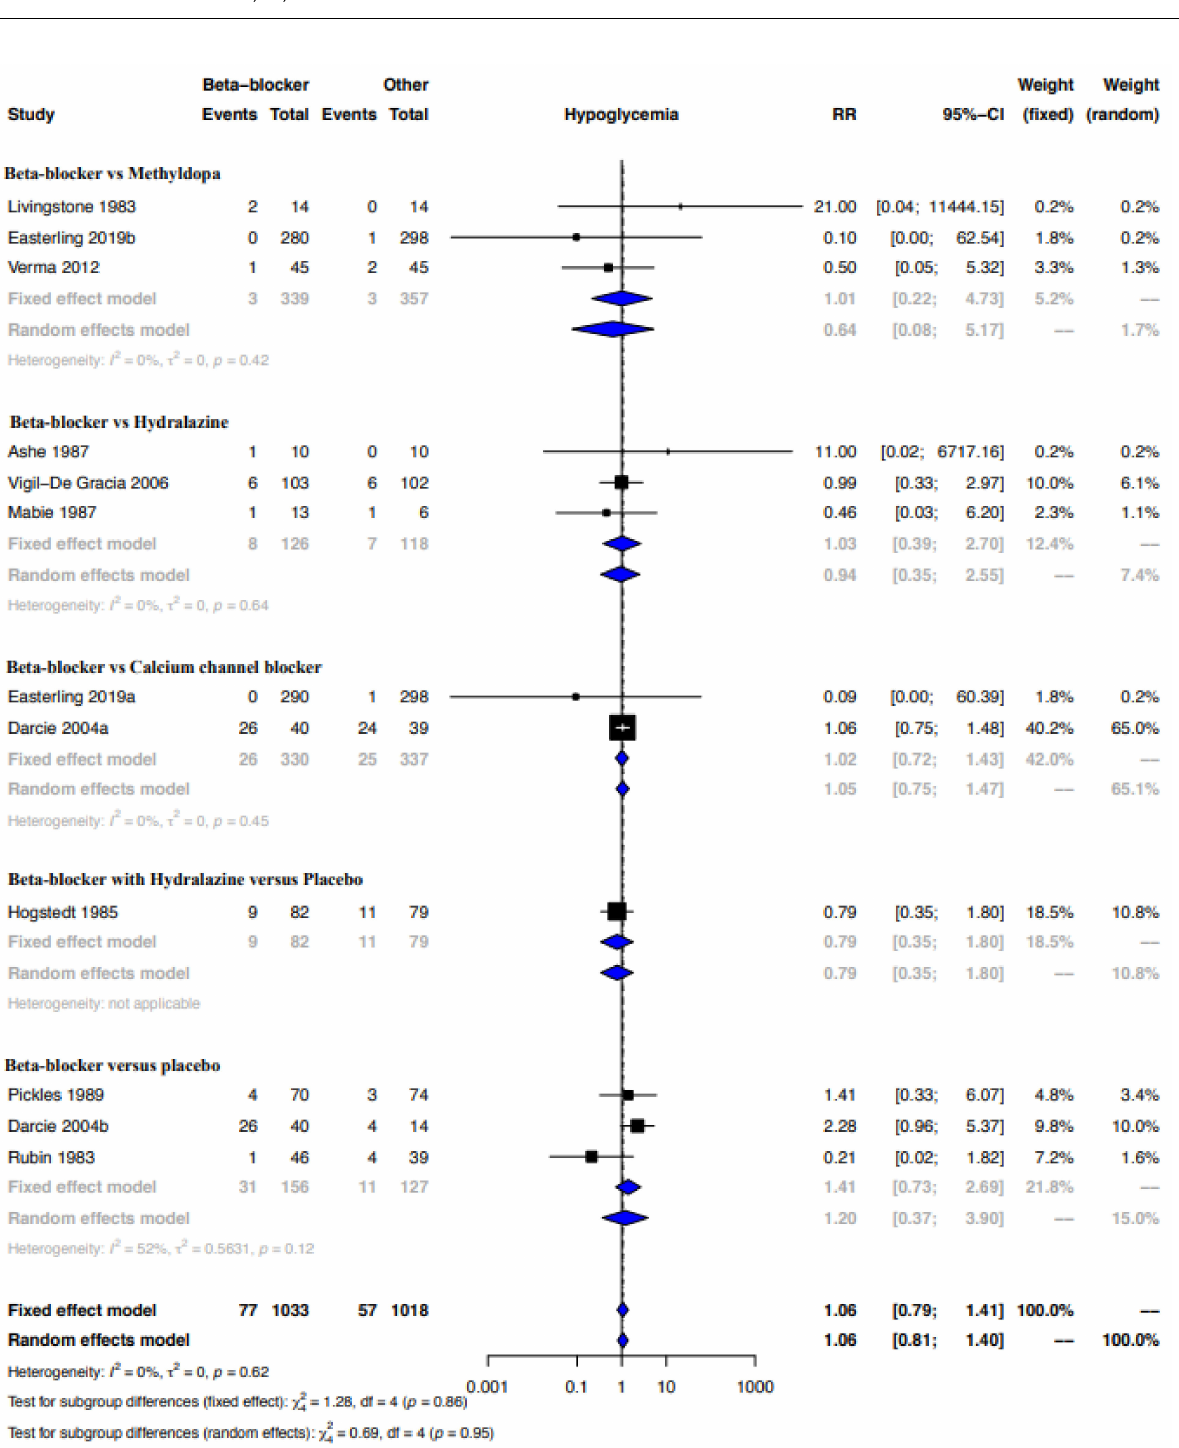
Figure 8. Meta-analysis hypoglycemia—RCT. Beta-blocker vs. methyldopa: [33,38,55]; beta-blockers vs. hydralazine: [40,46,47]; beta-blockers vs. calcium channel blockers: [33,41]; beta-blocker with hydralazine vs. placebo: [50]; beta-blockers vs. placebo